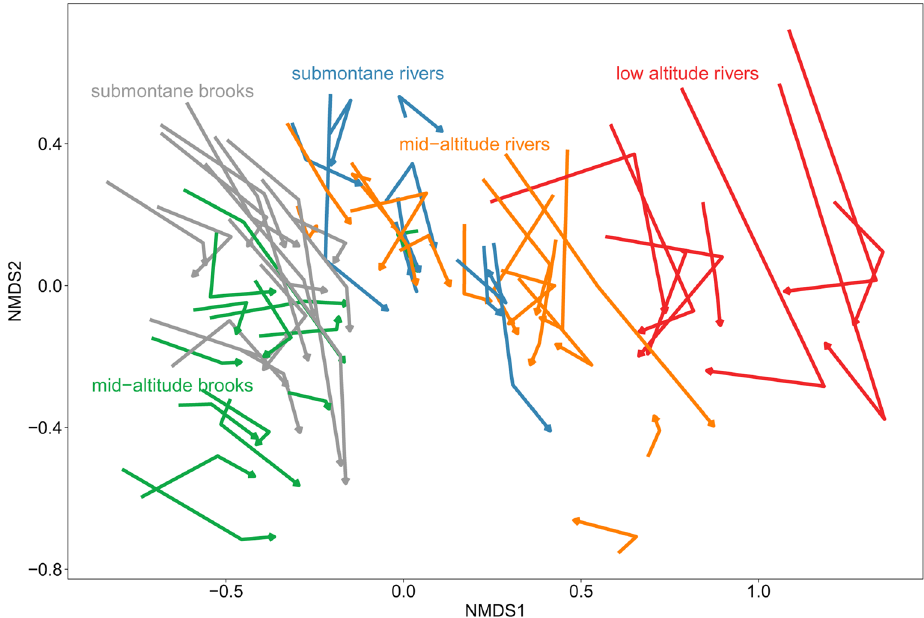
Figure 2. Compositional shift of macroinvertebrate assemblages in the 65 stream sites repeatedly sampled in 1997–2000 (period 1), 2007–2008 (period 2) and 2015 (period 3). Species data were analysed by Non-Metric Multidimensional Scaling (NMDS) on Bray–Curtis dissimilarities of ln(x + 1) transformed abundances; stress = 0.153. The sites are classified into five types along a river continuum. Samples from the sampling periods are connected by an arrow for each site, heading towards the youngest time